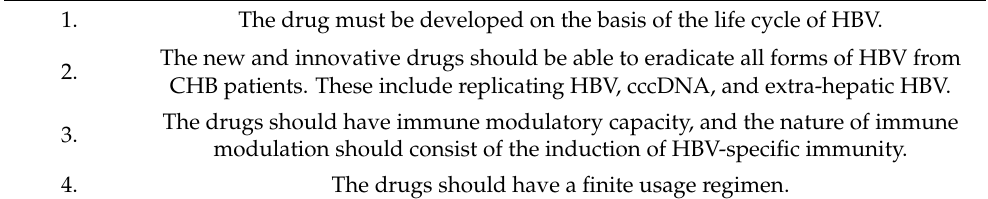
Figure 1. Points of interference by innovative therapy targeting HBV [21]. Table 2. Nature of ideal innovative antiviral